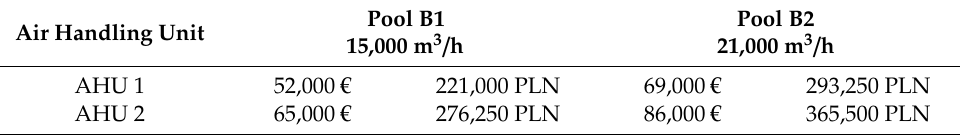
Table 4. Investments costs for purchasing air handling